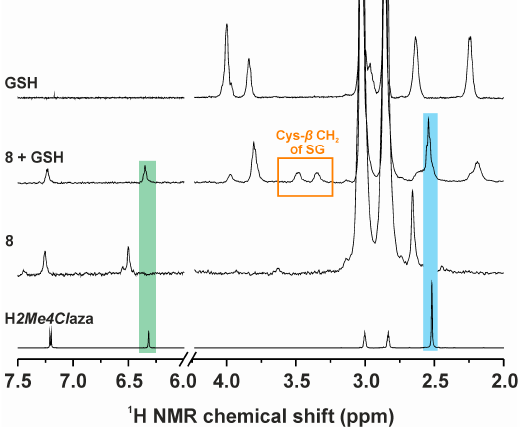
Figure 3. Proton nuclear magnetic resonance ( 1 H-NMR) spectra of [Au( 2Me4Cl aza)(PPh 3 )] ( 8 ) and its mixture with reduced glutathione ( 8 + GSH) recorded after 48 h of standing at ambient temperature, given together (for comparative purposes) with the 1 H-NMR spectra of free H 2Me4Cl aza and GSH. All samples were studied in the 50% DMF- d 7 /50% D 2 O solution. Green: C3–H signal of H 2Me4Cl aza; blue: CH 3 signal of H 2Me4Cl